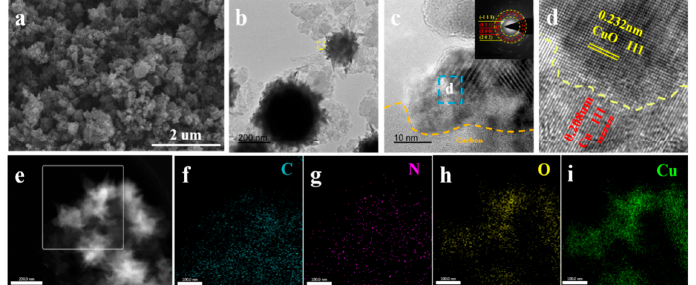
Figure 3. Morphologic characterization of Cu/CuO@NC-900. ( a ) SEM image; ( b ) TEM image; ( c ) HRTEM image taken from the yellow dotted frame of Figure 3(b) (inset: SAED pattern of the Cu/CuO@NC-900); ( d ) Enlarged HRTEM image from Figure 3(c); ( e ) STEM image (The white box is the selected area of EDX mapping images) and corresponding ( f – i ) EDX mapping images of C, N, O, and Cu elements in Cu/CuO@NC-900.